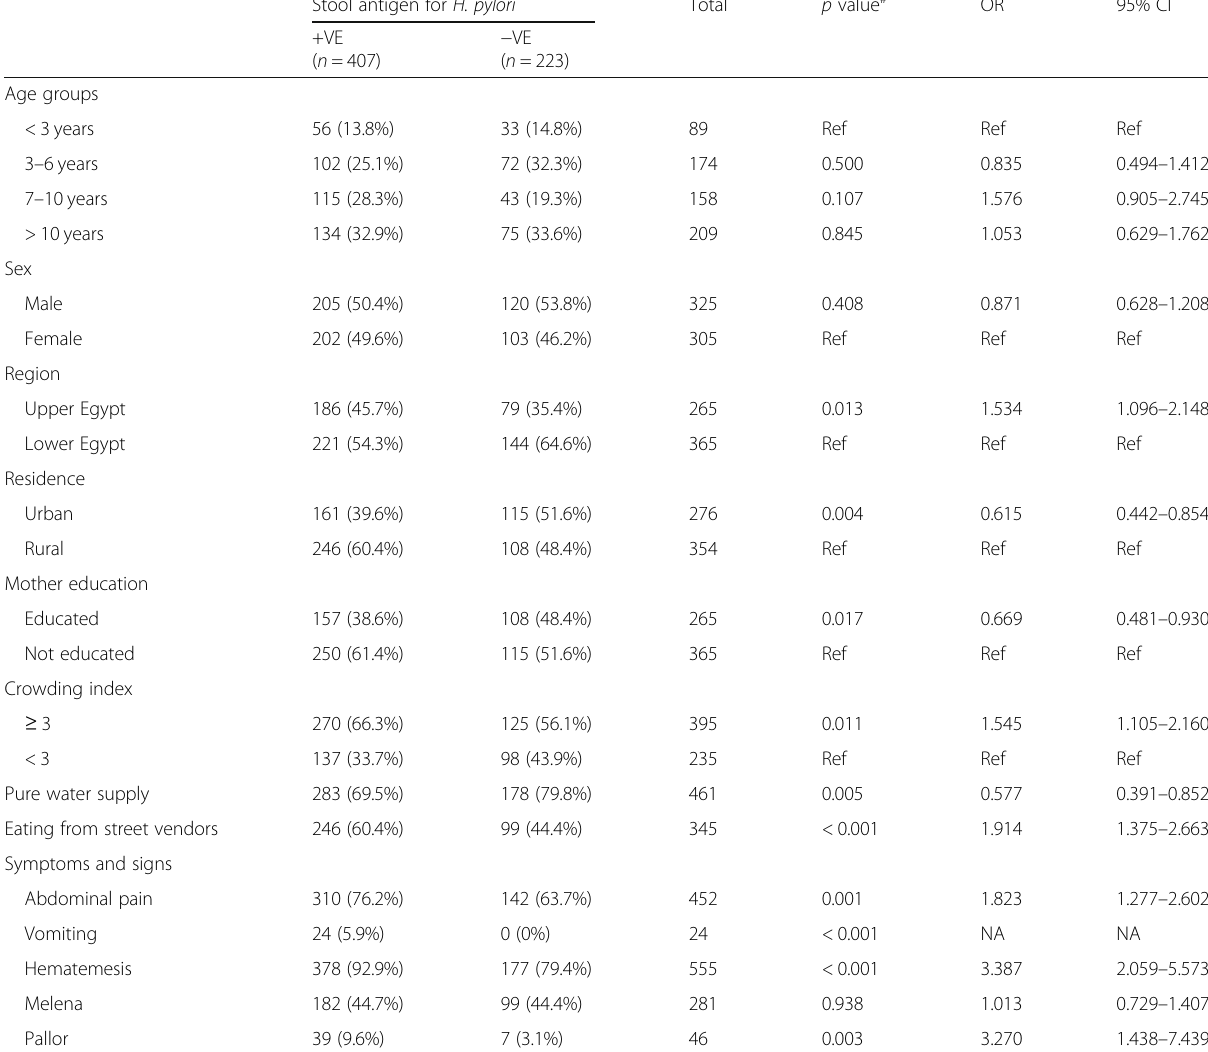
Table 1 Association of H. pylori infection among symptomatic Egyptian children with sociodemographic, personal, and clinical data Stool antigen for H.